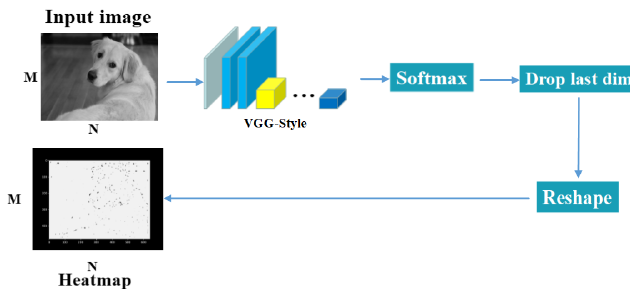
Figure 2. Learning point-based detection